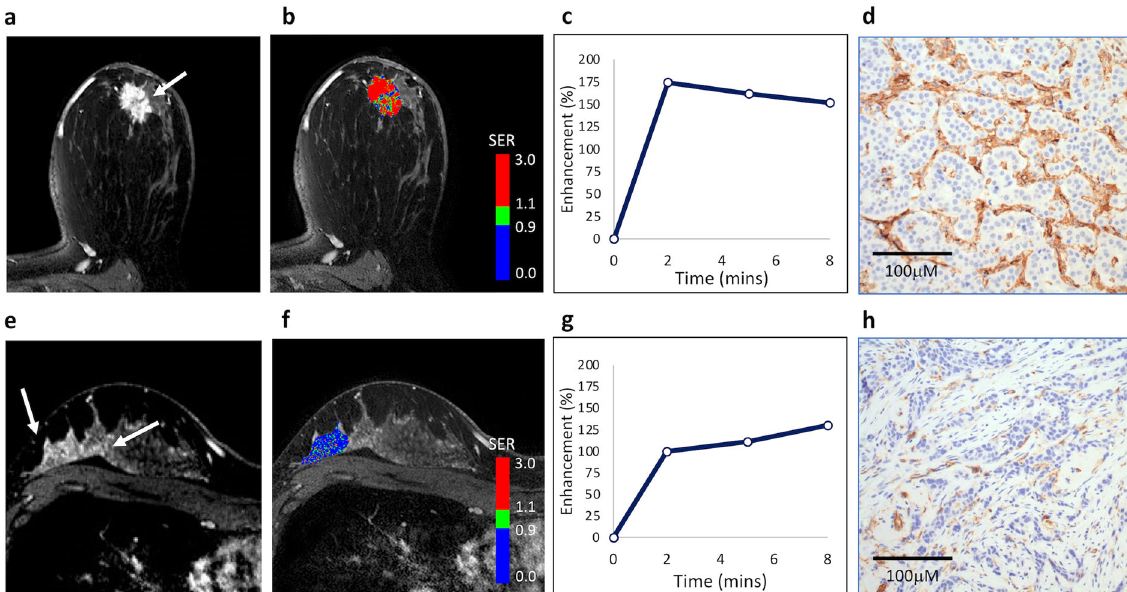
Fig. 2 DCE-MRI characteristics in two malignancies with different levels of microvessel density. Top row: a 44-year old woman with biopsy- proven grade II invasive ductal carcinoma. a DCE-MRI demonstrates an enhancing lesion in the subareolar region of the left breast (arrow). b Kinetics analysis shows rapid contrast enhancement and washout, with predominantly high signal enhancement ratio (SER), with peak SER = 2.1 (initial peak percent enhancement [PE] = 310%, functional tumor volume [FTV] = 4.9 cm 3 , and washout fraction [WF] = 56%; red indicates areas of washout [SER ≥ 1.1]). c Plot of overall lesion enhancement (%) versus time after contrast injection demonstrates high early peak enhancement and washout by 8 min. d Histologic staining for CD31 indicates high microvessel density (MVD; shown at ×400 magni fi cation), with mean vessel count = 56. Bottom row: a 34-year old woman with biopsy-proven grade III invasive ductal carcinoma. e DCE- MRI demonstrates an enhancing lesion in the posterior right breast. f Kinetics analysis shows predominantly low SER, with peak SER = 1.3 (initial peak PE = 218%, FTV = 4.8 cm 3 , and WF = 6%)), with mean vessel count = 9. g Plot of overall lesion enhancement (%) versus time after contrast injection demonstrates persistent enhancement over 8 min. h Histologic staining for CD31 indicates low MVD (shown at ×400 magni fi cation).